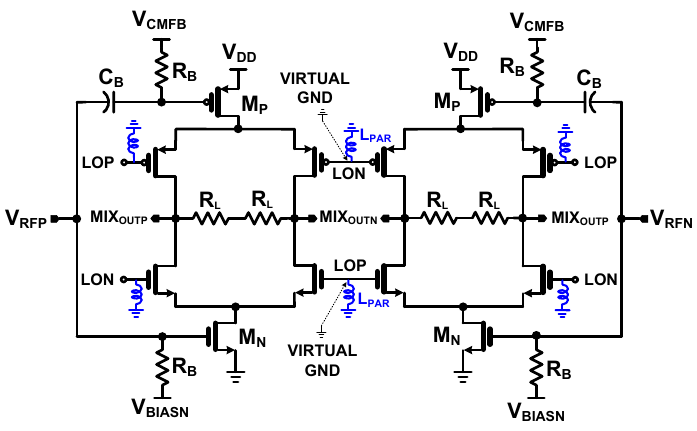
Figure 6. Schema of the double-balanced